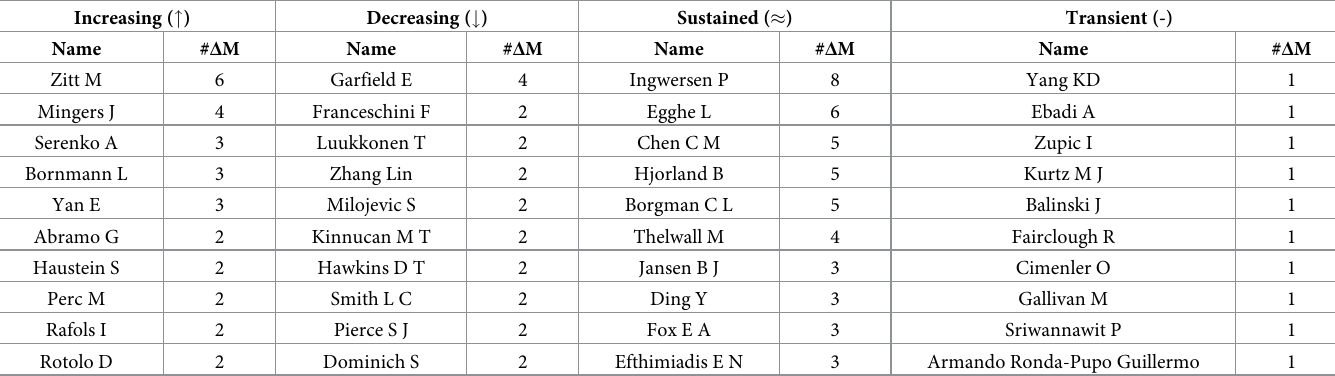
Table 4. Top 10 researchers of each type and, # Δ M, the number of intervals in which they have a non-zero Δ M. Increasing ( " )